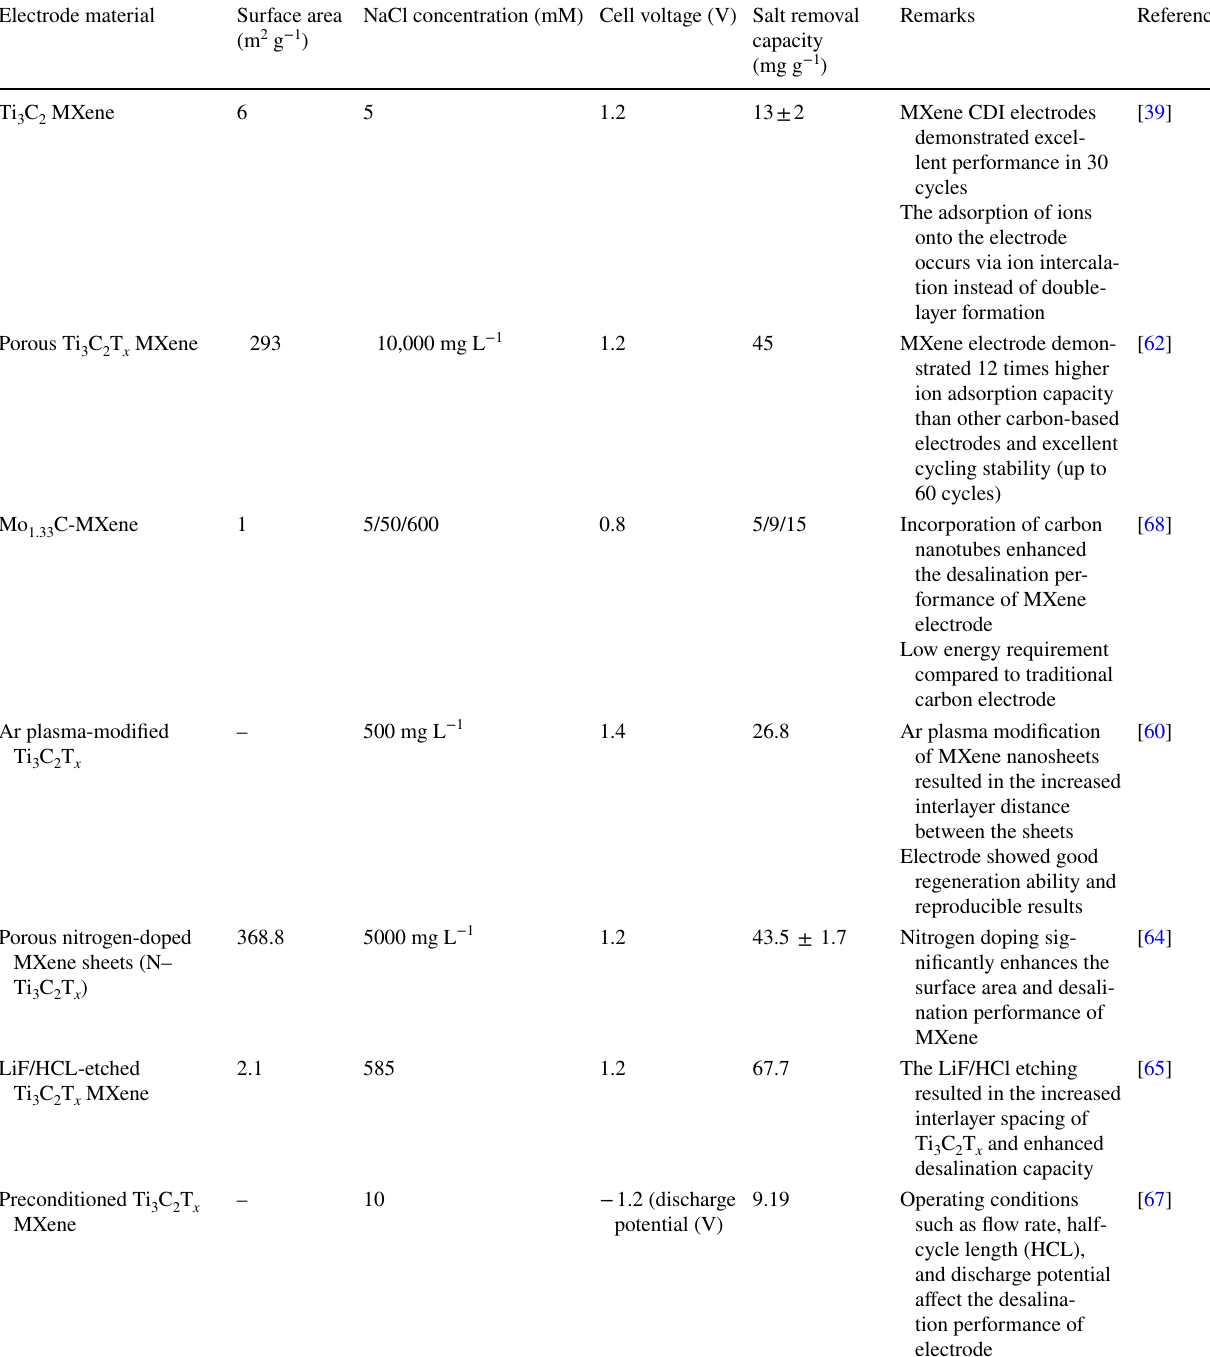
Table 2 Desalination performance of MXene electrodes in CDI Electrode material